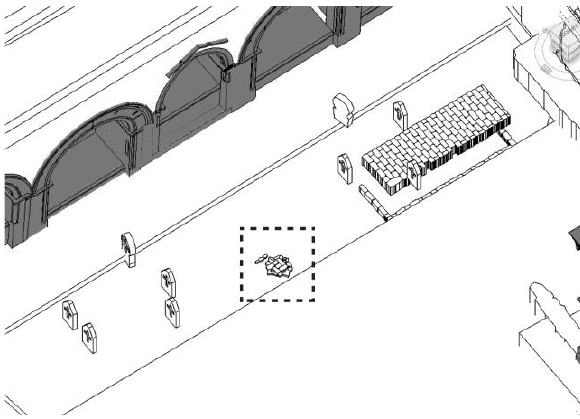
Figure 5. 3D view highlighting the tourist landmarks.